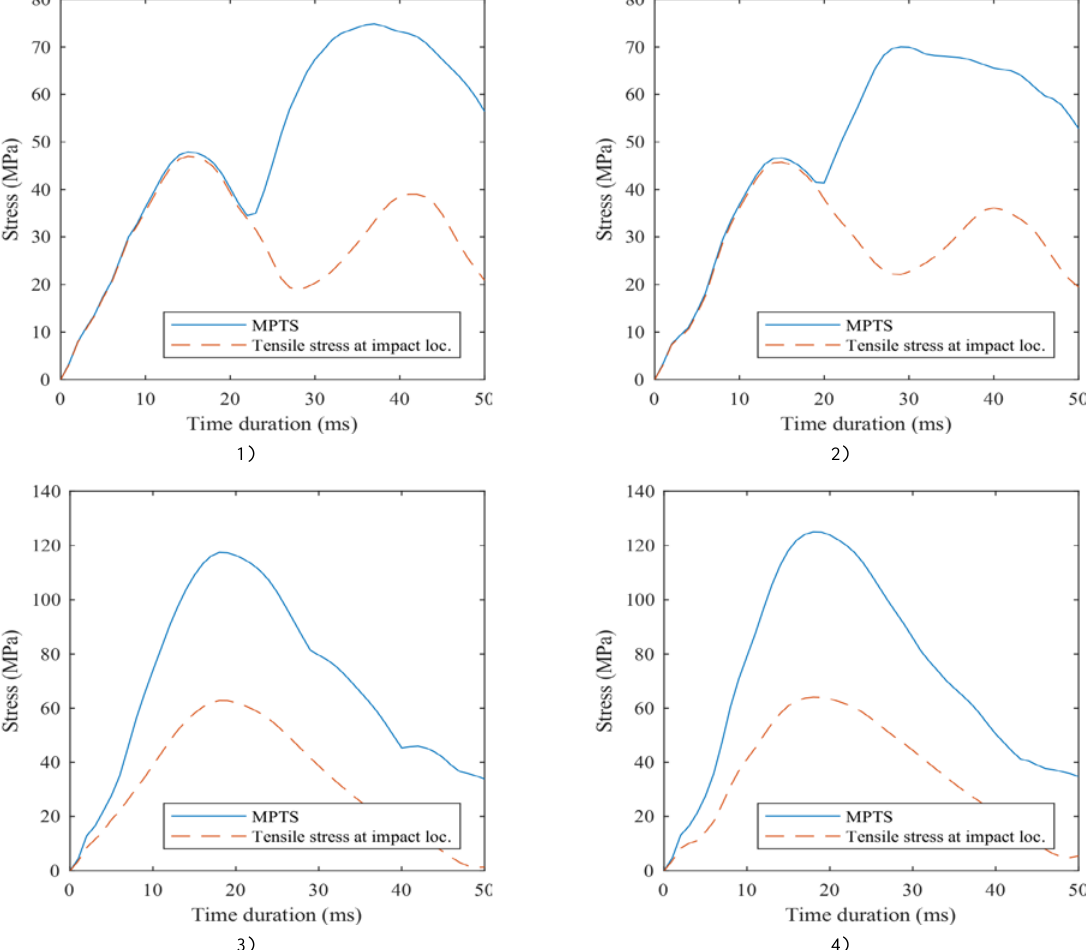
Fig. 5 Results of numerical simulations. Maximum principal tensile stress and tensile stress at the impact location (on opposite face of panel) in the four impact location cases.